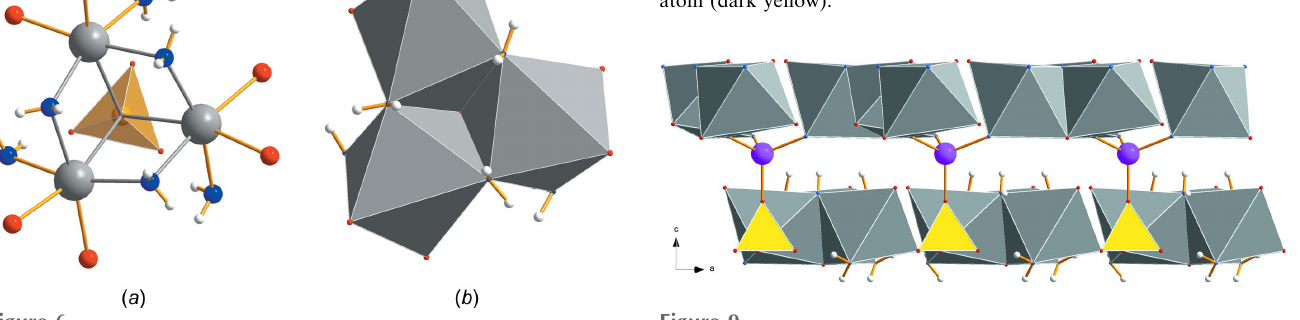
Figure 9 Interconnections of sodium layers by sulfate tetrahedra with the S2 sulfur atom (dark yellow).